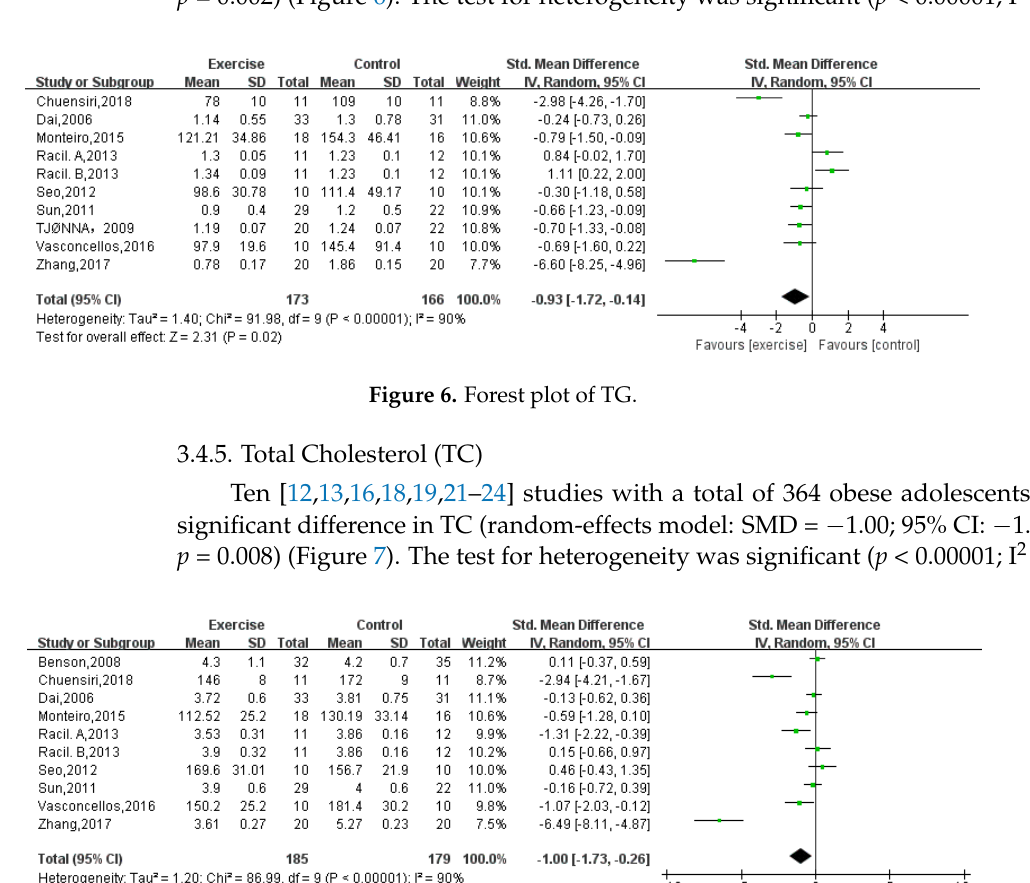
Figure 5. Forest plot of LDL-C.